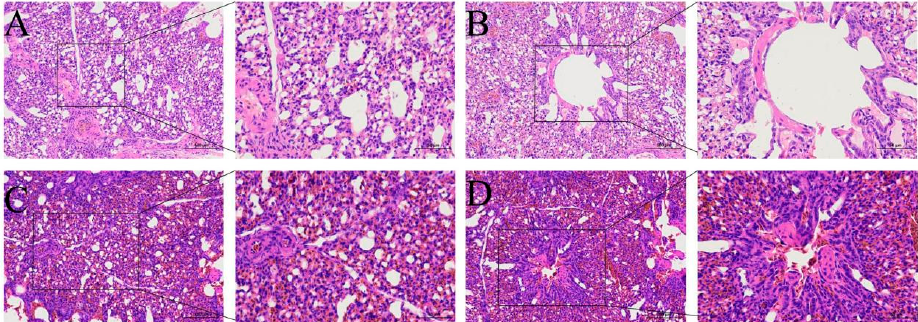
Figure 2. Hematoxylin and eosin-stained lung tissue (200 × /400 × ). ( A , B ) The normal group. A: the pulmonary tissue structure and pulmonary vascular wall. B: the lung chamber. ( C , D ) The model group. ( C ) Pulmonary congestion and respiratory capillary atrophy. ( D ) Pulmonary atrial stenosis.